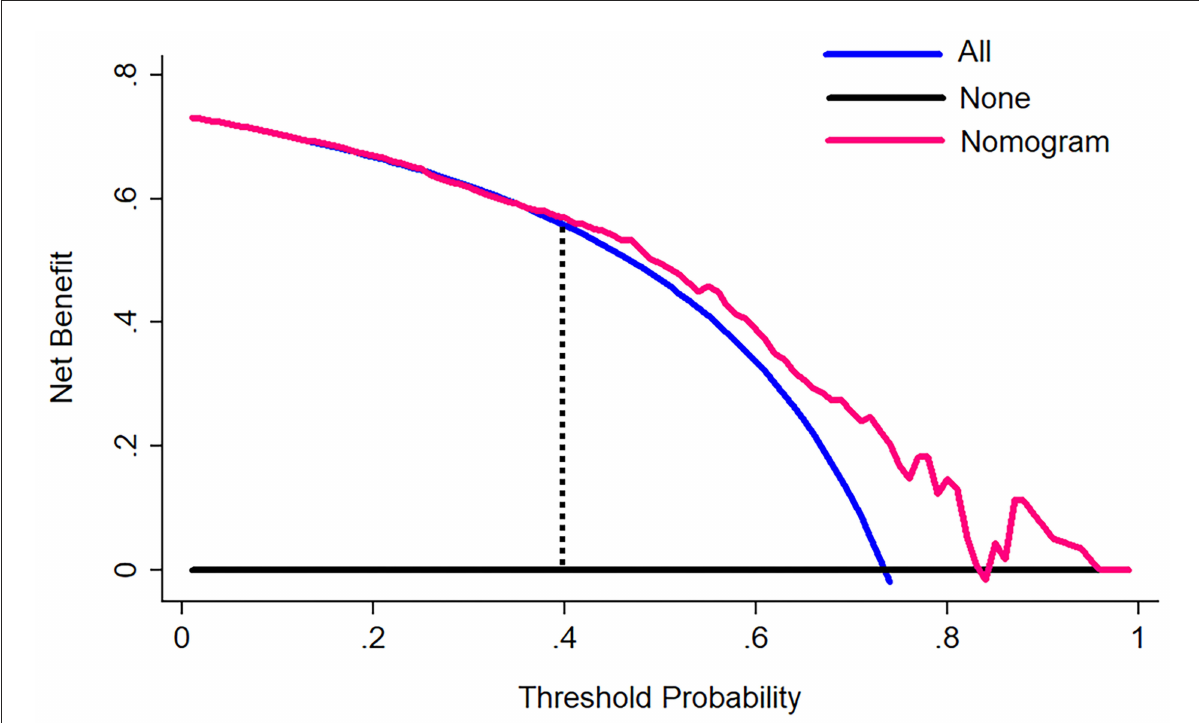
FIGURE5 A decision curve analysis for the nomogram. The y -axis measures the net benefit. The pink line represents the nomogram. The blue line represents the assumption that all patients have self-absorption. The black line represents the assumption that no patients have self-absorption. The net benefit was calculated by subtracting the proportion of all patients who are false positive from the proportion who are true positive, weighting by the relative harm of forgoing treatment compared with the negative consequences of an unnecessary treatment. The decision curve showed that if the self-absorption probability of a patient > 40%, using the nomogram in the current study to predict self-absorption adds more benefit than either assumption that all patients have self-absorption or assumption that no patients have